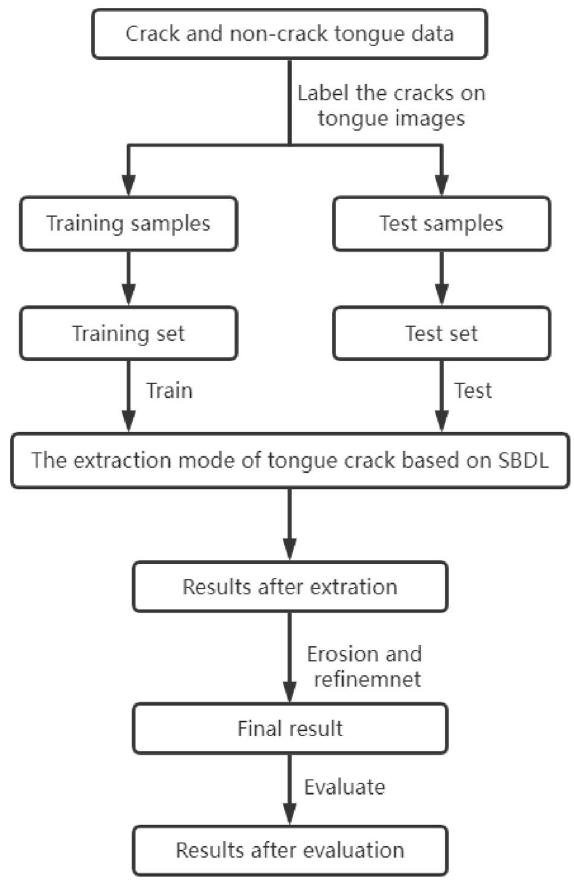
Figure 2. Flow chart of tongue crack extraction based on SBDL.